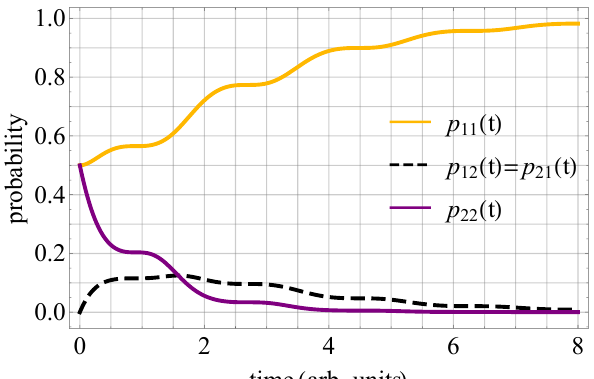
Figure 1. Plots present the probability of finding a two-qubit system in one of the possible states. The initial state is represented by (15).